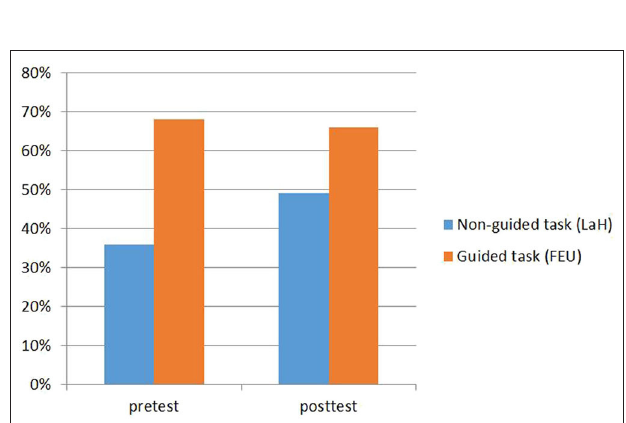
FIGURE 6 | Comparison of solution rates related to two different items (control group).